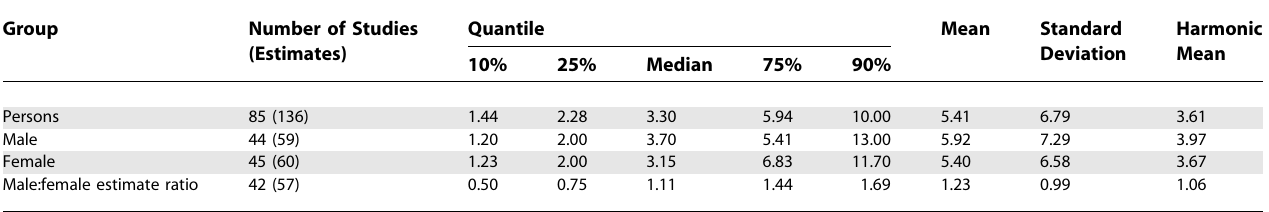
Table 8. Quantiles and Moments of Combined Prevalence Estimates per 1,000 by Sex, and Male:Female Prevalence Estimate Ratio Group Number of Studies (Estimates)